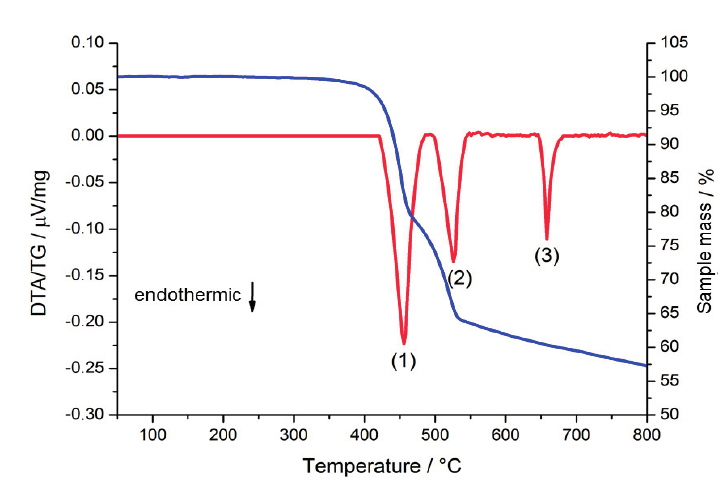
Figure 7 . Simultaneous DTA/TG investigations on 2 ∞ [Sm 3 Cl 9 (bipy) 3 ] ( 3 ) using a heating rate of 10 °C/min. DTA curve: red; TG curve: